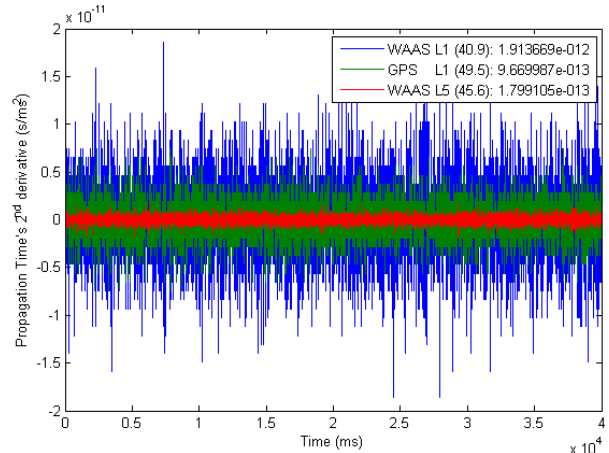
Figure 11. Propagation Time Noise During 40 sLegend: (signal type) (cid:4666)< (cid:2159) (cid:2170) (cid:2777) ⁄